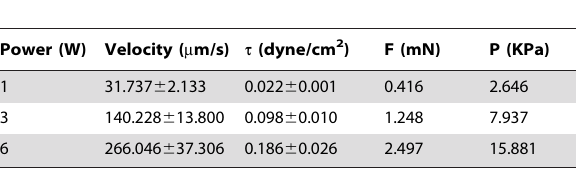
Table 1. Calculated Dynamic Parameters for Different Acoustical